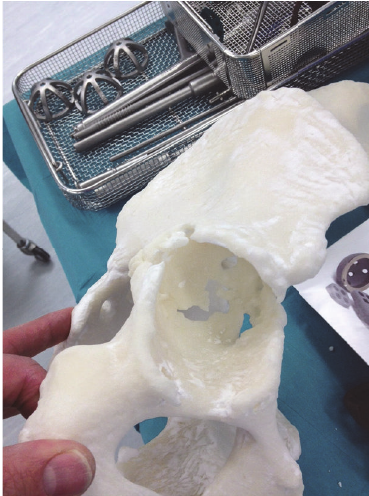
Figure 11: Examining the left acetabulum showing a posterosu- perior deficiency. The right acetabulum shows significant central discontinuation due to bone loss (note: these figures in print journal are two-dimensional, thus limiting the true demonstration of the value of 3D printed models in providing an accurate understanding and representation of the complex deformities and corrective reconstructive techniques).